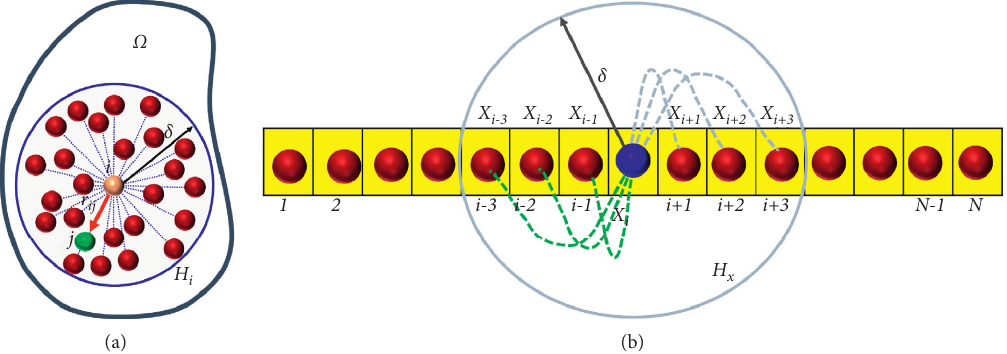
Figure 2: Peridynamics concept representation: (a) peridynamic medium representation; (b) 1D peridynamic medium